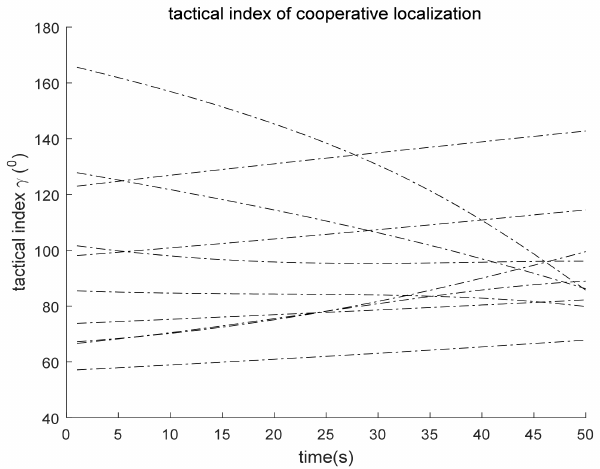
Figure 16. Intersection angle γ between direction and time difference localization platform and each point of the target